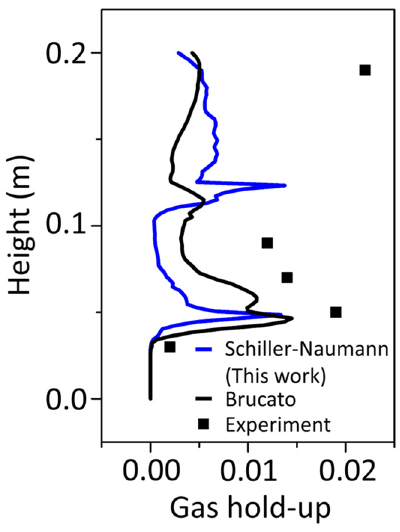
Figure 7. Axial distribution of the gas hold-up at x = 0.03 m with different drag models and experimental values [38] with 500 RPM and inlet velocity of 0.1 m/s.